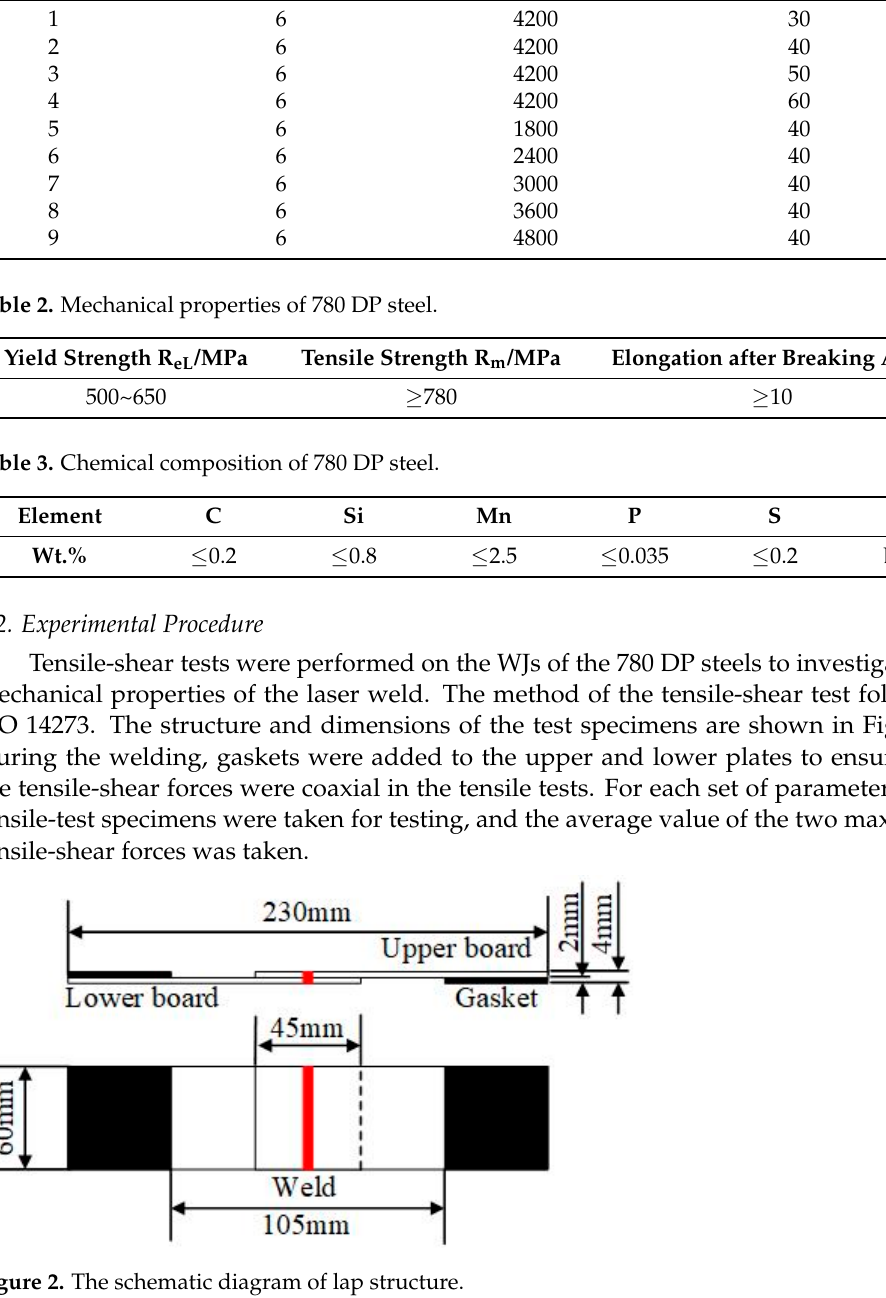
Table 1. Welding parameters. Table 2. Mechanical properties of 780 DP steel.